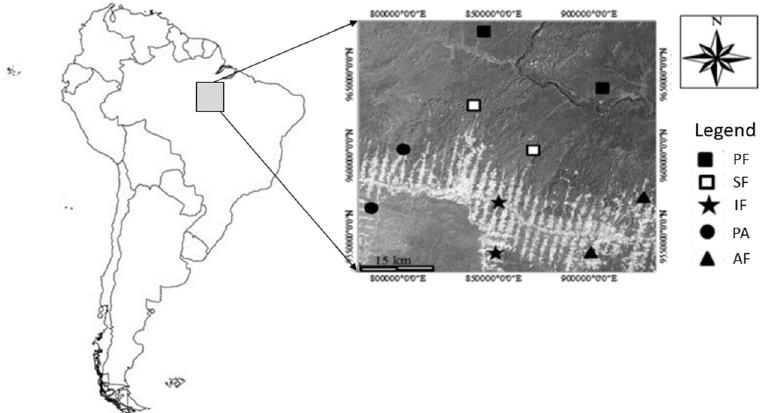
Figure 1. Study region of municipality of Uruará, state Pará, northern Brazil. Location of the ecosystem sampling sites: Primary Forest (PF), Secondary Forest (SF), Incipient succession (IF), Agroforestry (AF)—cocoa plantations, and Pasture for extensive livestock (PA).